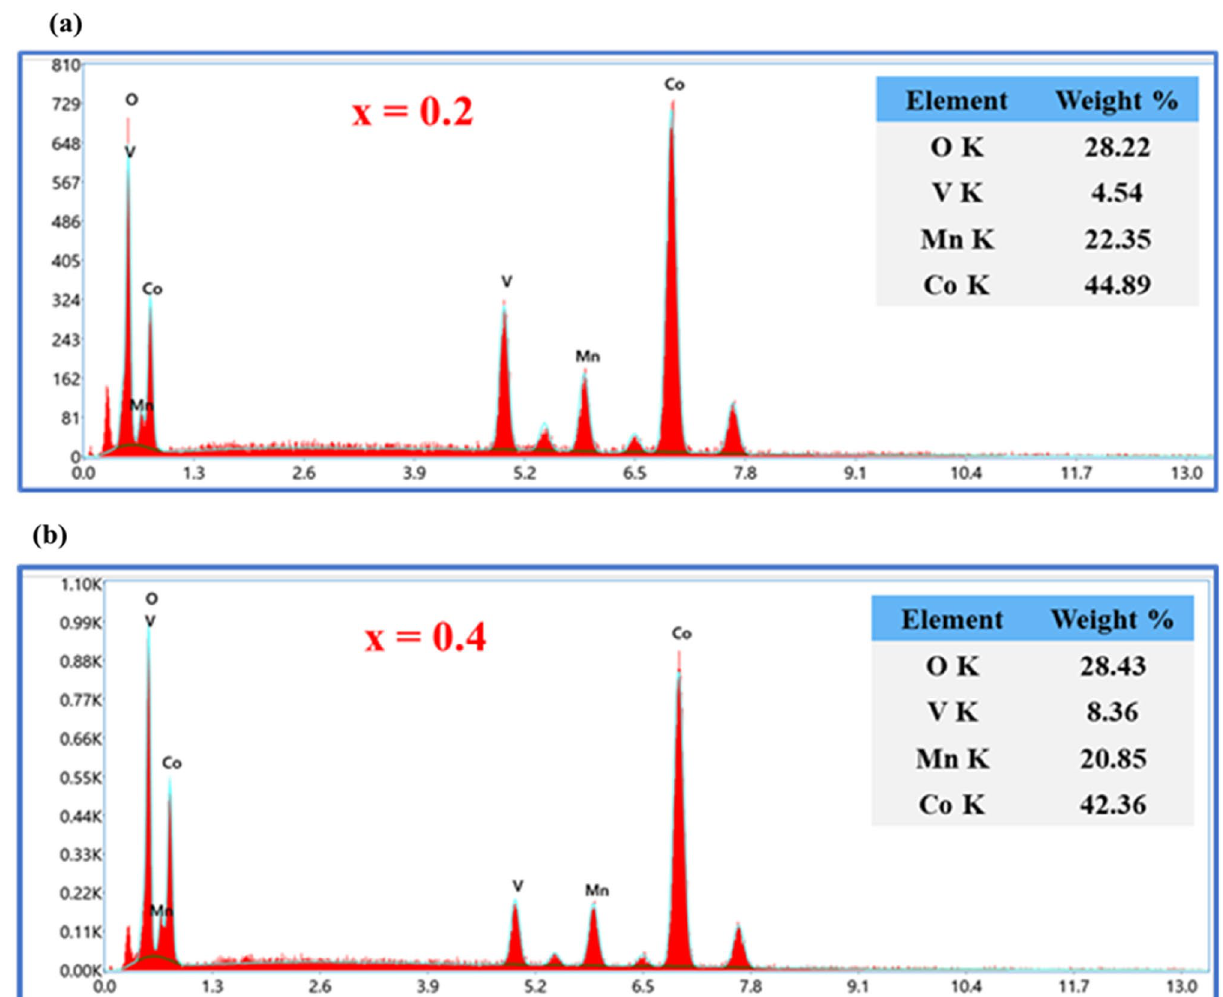
Figure 4. EDX spectrum of V x -MnCo samples for x = (a) 0.2 MCs, and (b) 0.4